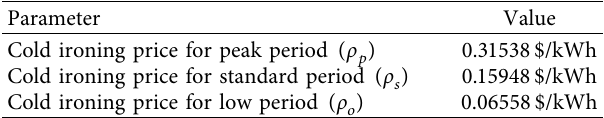
Table 2: HEMS assessed